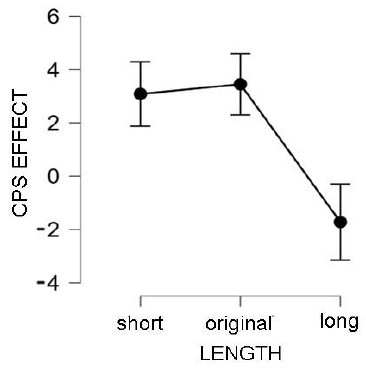
Figure 3. CPS effect across the three length (pre-boundary lengthening) conditions. Vertical bars represent 95% confidence intervals; The CPS effect refers to whole-scalp-averaged voltage values resulting from B – A at IPH 2 minus B – A at IPH 1 and is expected to be positive.